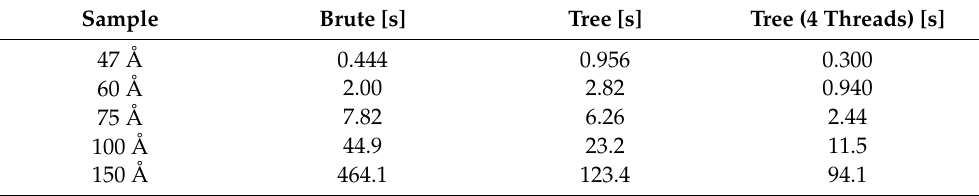
Table 2. Computational cost of a single attosecond timestep in XMDYN for samples of different size (first column) when using Coulomb brute-force scheme (second column), single threaded Coulomb PEPC tree code (third column), and the 4 threaded Coulomb PEPC solver (fourth column). The secondary ionization solver used in the calculation was the default one, i.e., the non-tree solver. Sample Brute [s] Tree [s] Tree (4 Threads)